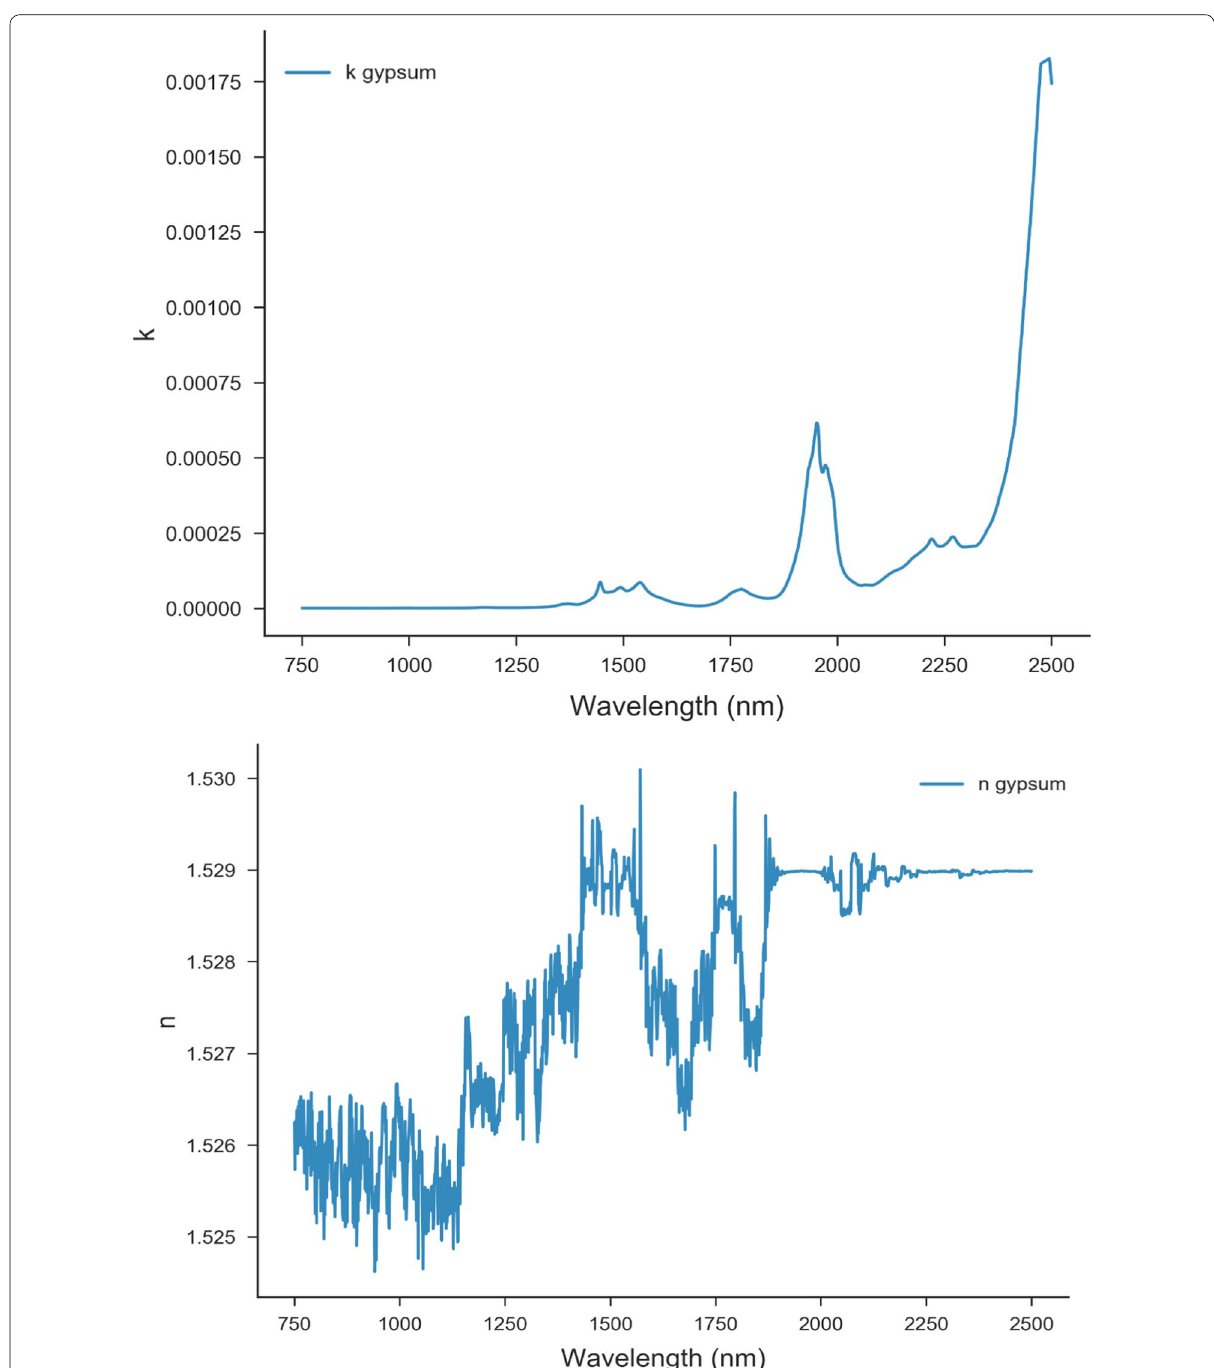
Fig. 5 The optimized n and k values for